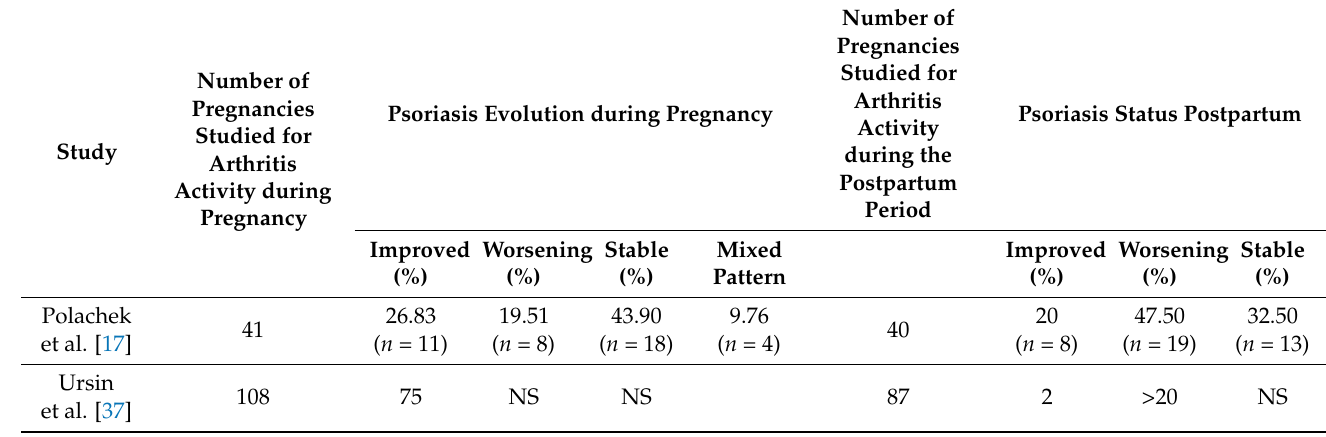
Table 1. Psoriatic arthritis disease activity during pregnancy and postpartum.